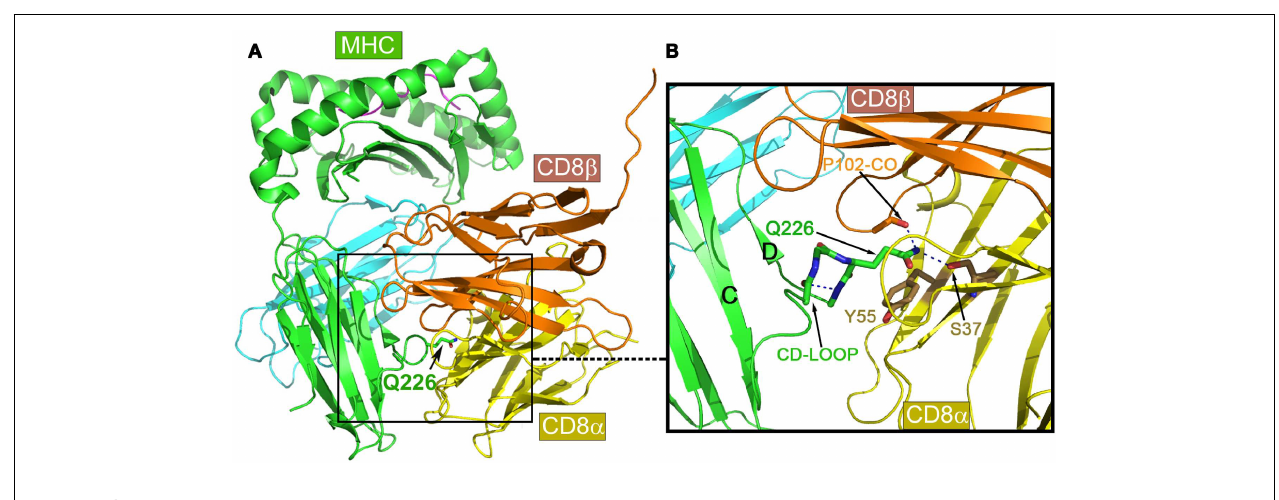
FIGURE 4 | Structure of mouse CD8 αβ in complex with the MHCI molecule H-2D d . (A) An overview of the complex. (B) Details of the binding region. Note that the key conserved Q226 from MHCI molecule’s CD loop pokes into a crevice formed between CD8 α and β